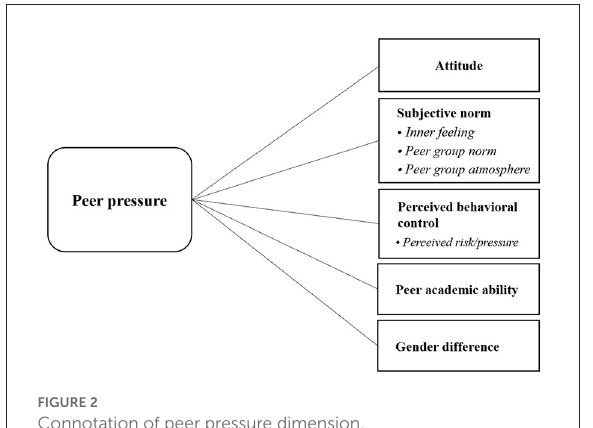
FIGURE2 Connotation of peer pressure